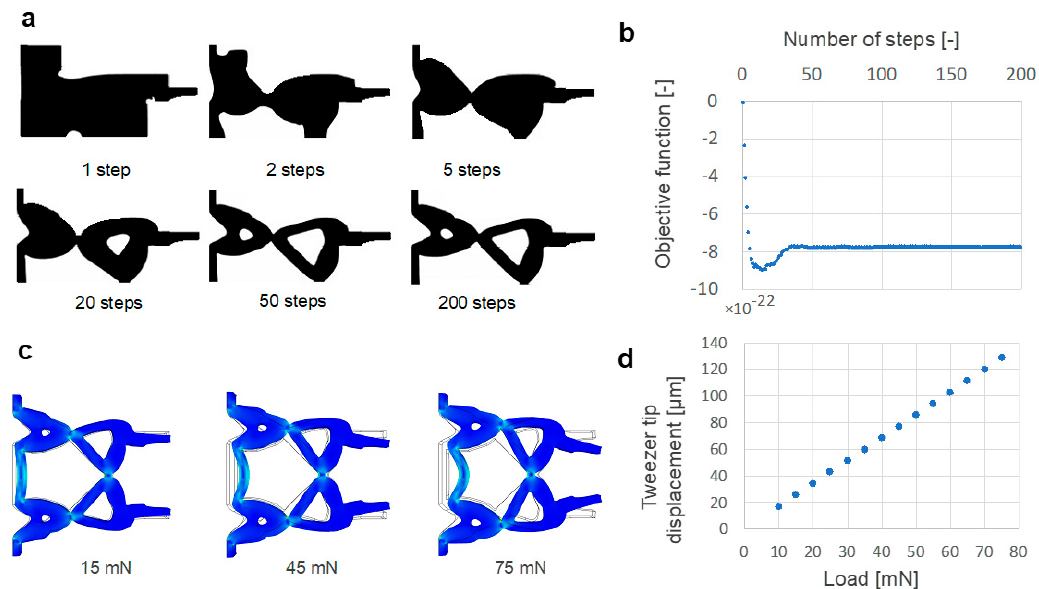
Figure 4. Results of topology optimization and finite element analysis: ( a ) Shape transition based on the number of calculation steps; ( b ) Convergence of the objective function; ( c ) Simulation results of the deformation of tweezers when the load is applied to the input of the tweezers (15 mN, 45 mN, 75 mN); ( d ) Displacement of the tweezer tip.